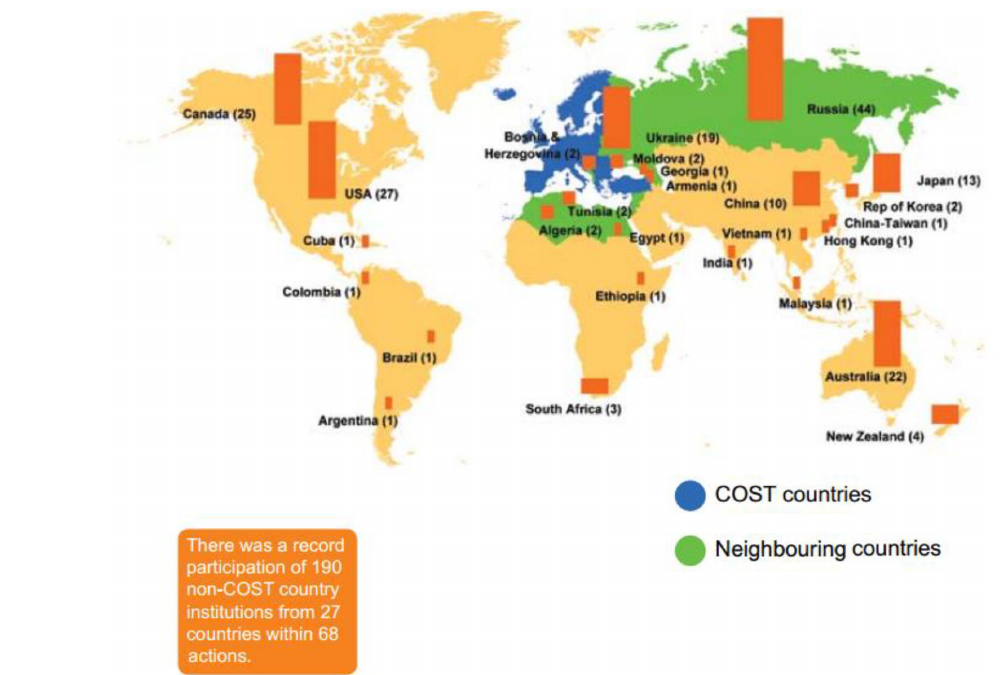
Figure 5. Map of COST, neighbouring, and non-COST countries participating in different Actions (from the COST Annual Report, May 2008, www.cost.eu, last access: 15 May